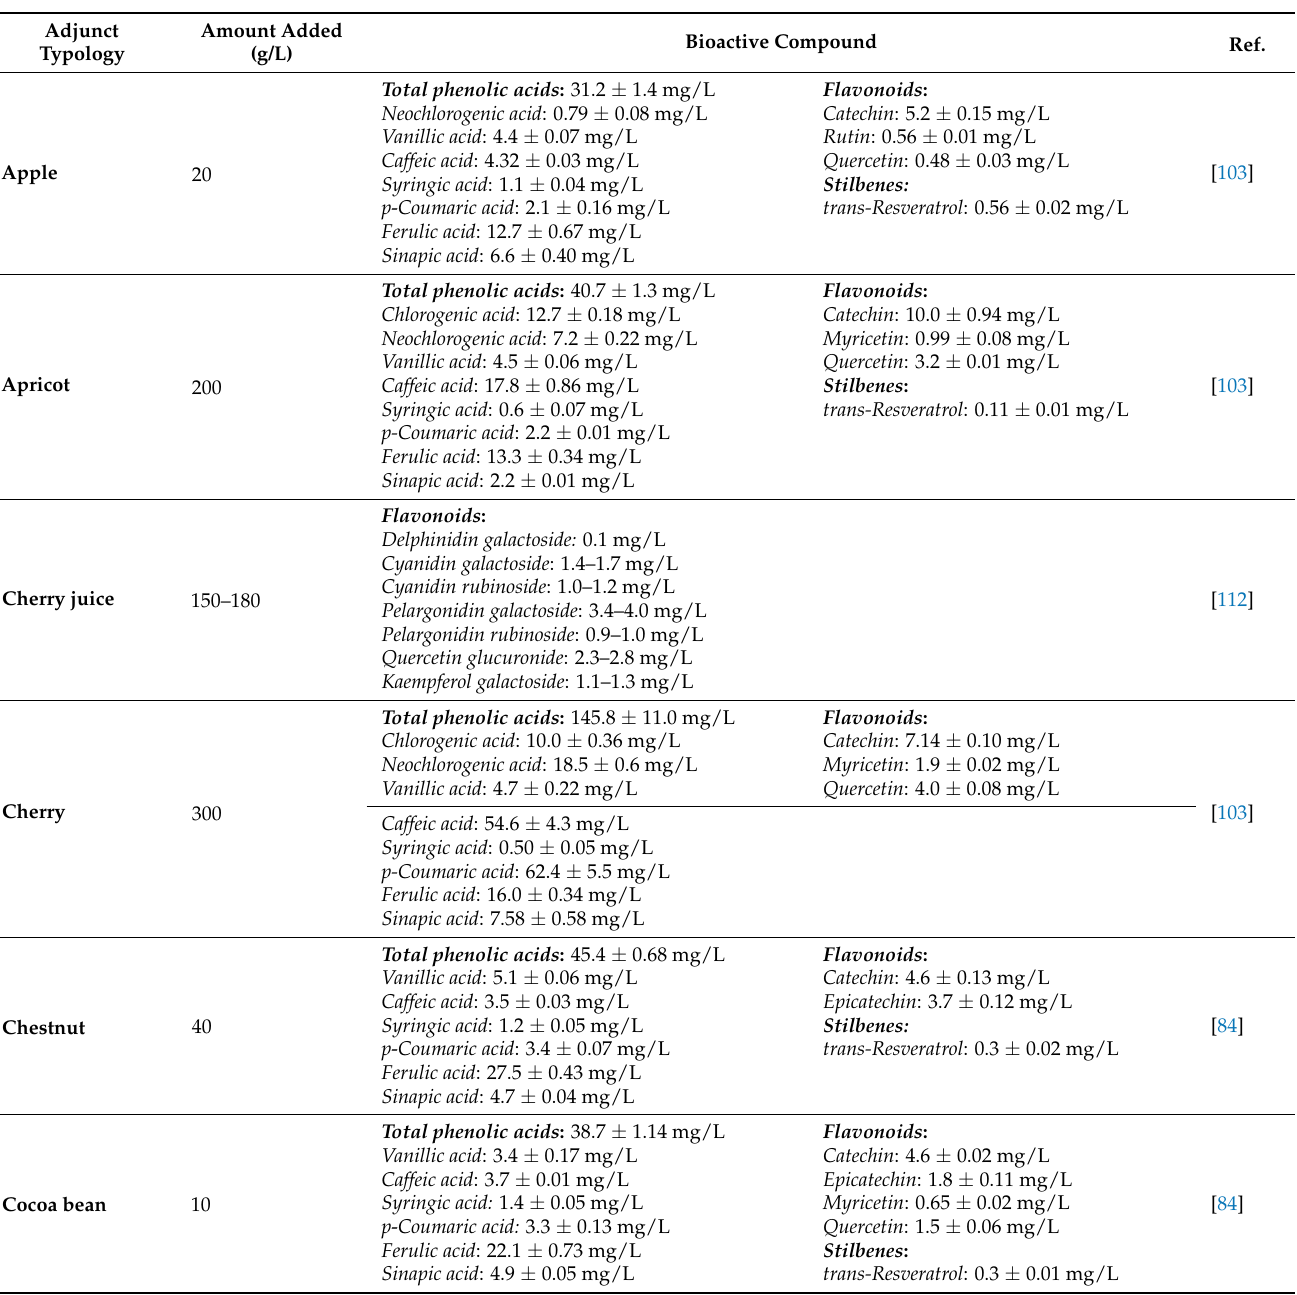
Table 4. Bioactive phenolic compounds in beers with added fruits, vegetables, herbs, and natural